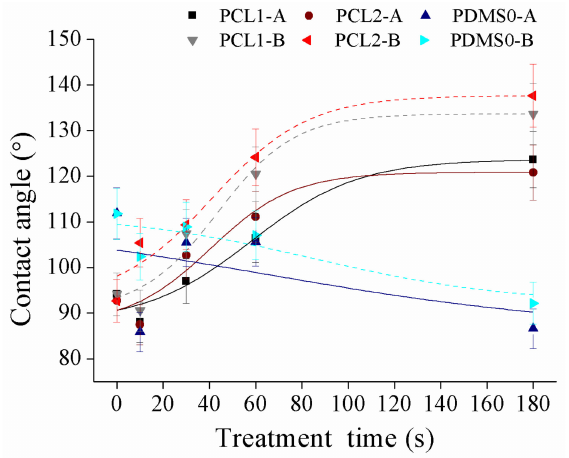
Figure 5. The water contact angle of PCL and PDMS films after treatment with CF 4 at different parameter settings.